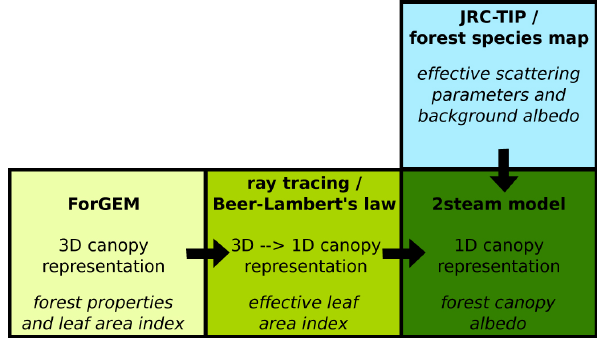
Fig. 1. Sketch of the model chain linking the forest gap-model, ray tracing, two-stream radiation transfer model and remote-sensing- based model parameters. Model output is given at the bottom of each box and the dimensions of the canopy representation are indi- cated by 3-D and 1-D for a three-dimensional and one-dimensional representation of the forest canopy, respectively. The variables cal- culated by the single models are in italics. ForGEM: Forest Ge- netics, Ecology and Management; JRC-TIP: Joint Research Centre Two-stream Inversion